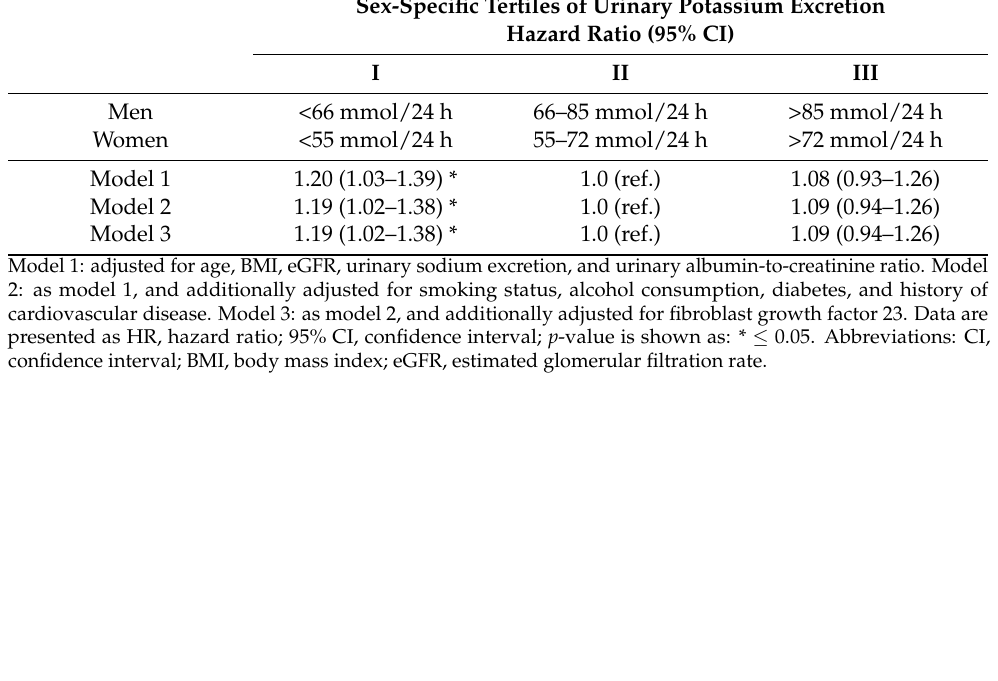
Table 3. Associations between urinary potassium excretion and risk of incident hypertension in 3720 PREVEND